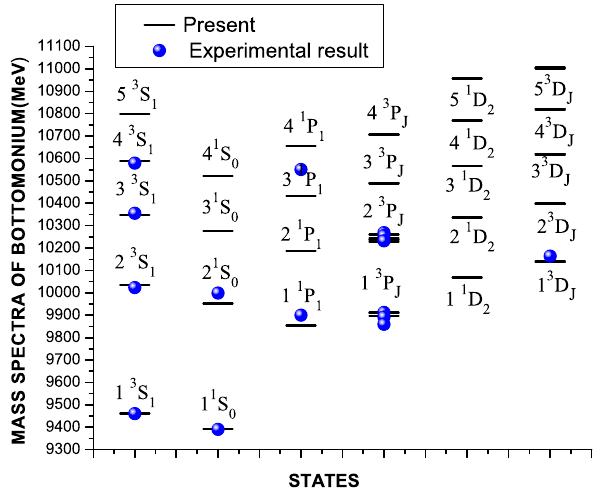
Fig. 1 Mass spectrum of Bottomonium the spin–orbit term has been split into symmetric (σ Q + σ ¯ and anti-symmetric (σ Q − σ ¯